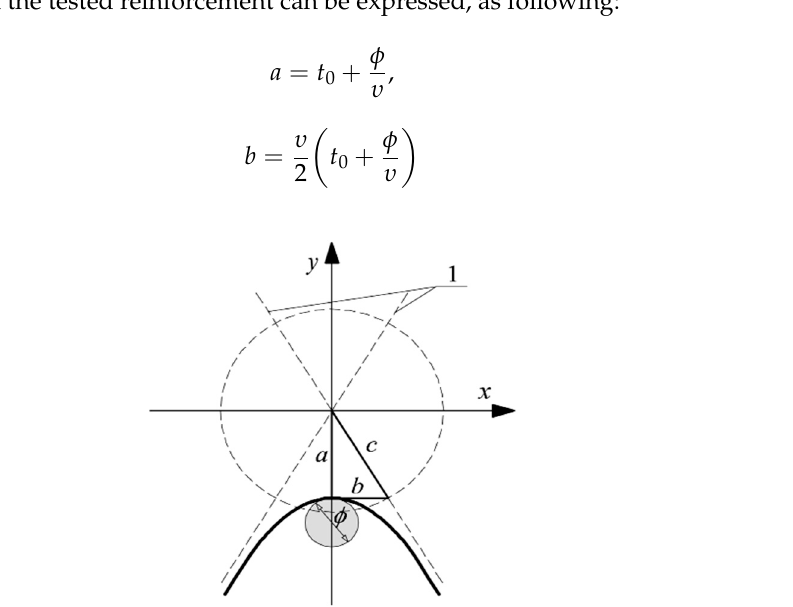
Figure 2. Assumptions to derive Equations (5) and (6), 1—hyperbola asymptotes.